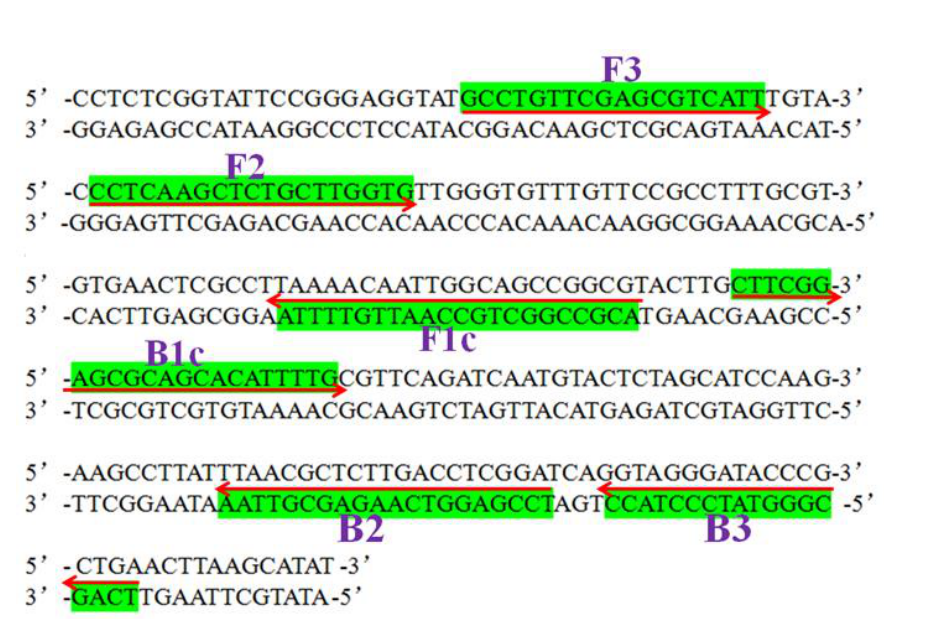
Figure 1. Design of LAMP primers for detection of M. cerina . The letters (F2, F3, B1c, F1c, B2 and B3) are primer names, the location and sequence of primers are shown in green color, and the direction of amplification is indicated by red arrows. Table 2. LAMP assay primers for detection of M. acerina in this study.